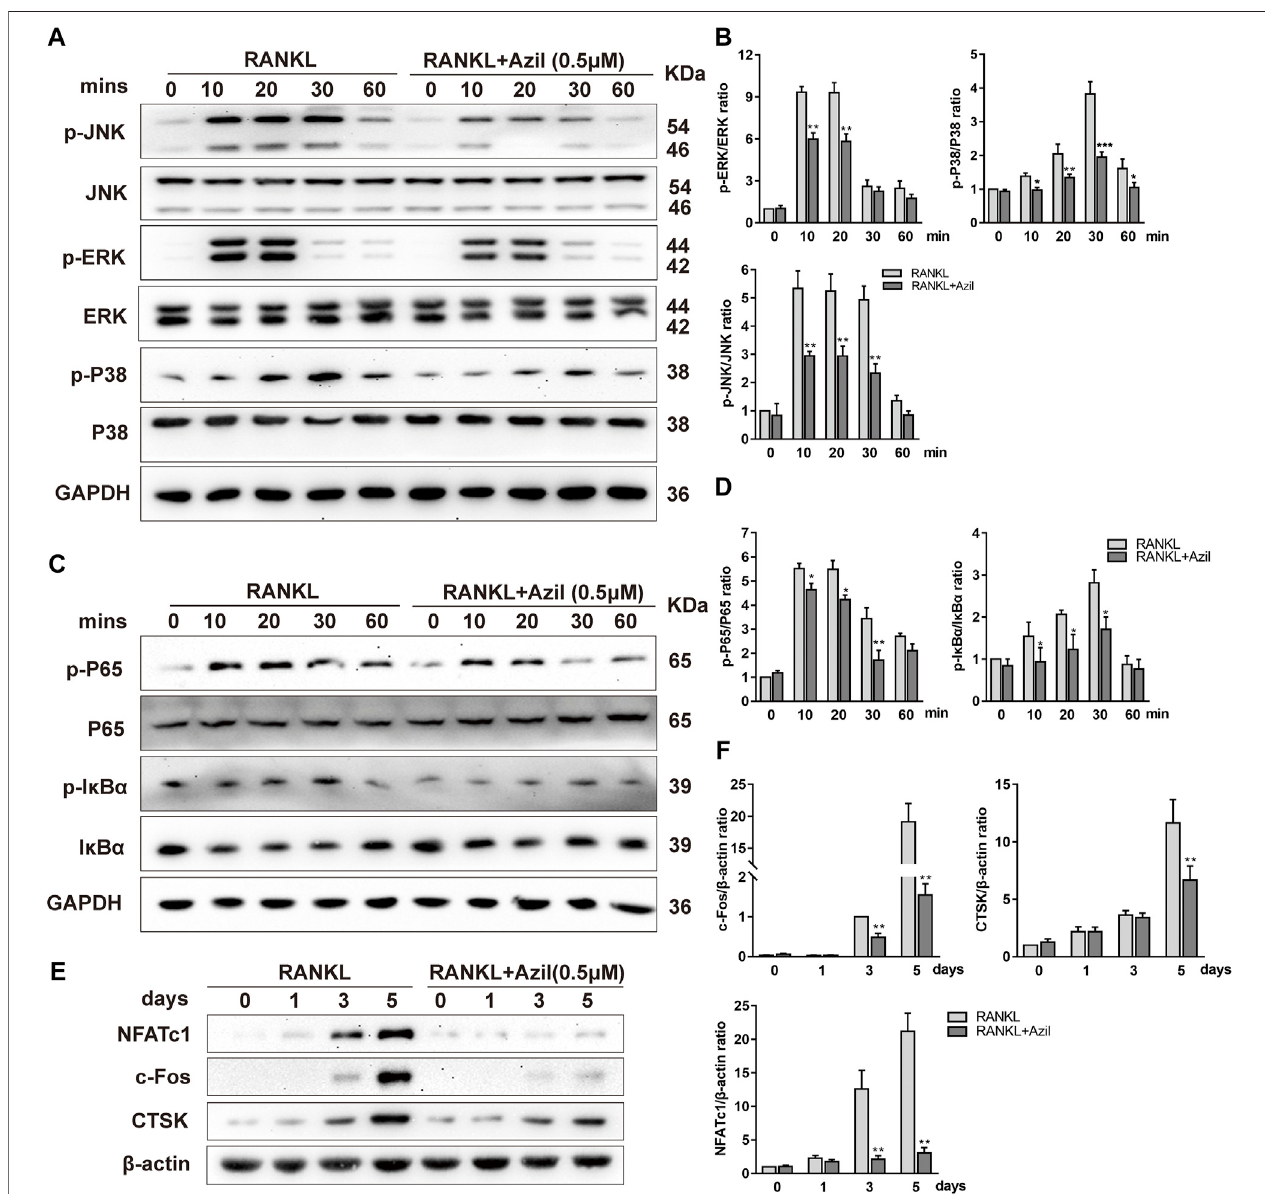
FIGURE3| AzilsartaninhibitsRANKL-inducedactivationofNF- κ BandMAPKPathways invitro . (A) BMMswerestarvedandpretreatedwithAzilsartan(0.5 µM)for 2 h before being stimulated by RANKL. Then, RANKL (100 ng/ml) was added at the indicated time points (0, 10, 20, 30, and 60 min). Total cellular proteins were collected and the phosphorylated and total P38/ERK/JNK were detected by Western Blot. (B) Quantitative analysis of phosphorylated P38/ERK/JNK band intensity relative to total P38/ERK/JNK using the ImageJ software ( n (cid:2) 3). (C) Western blot images showing the effects of Azilsartan on activation of NF- κ B signaling, including p-P65/p-I κ B α . (D) Quantitative analysis of phosphorylated P65/I κ B α band intensity relative to total P65/I κ B α ( n (cid:2) 3). (E) Western blot images showing the protein expression levels of NFATc1, c-Fos, and CTSK during osteoclastogenesis. BMMs were treated with RANKL (100 ng/ml) and the indicated concentration of Azilsartan (0.5 µM) for0, 1, 3, and 5 days; the total protein were extracted forWesternBlot analysis. (F) Quantitativeanalysis ofthe band intensity ofNFATc1,c-Fosand CTSK relative to β -actin using the ImageJ software ( n (cid:2) 3). All data were obtained from three independent experiments and were shown as mean ± SD. (* p < 0.05, ** p < 0.01, *** p < 0.005, compared with the RANKL